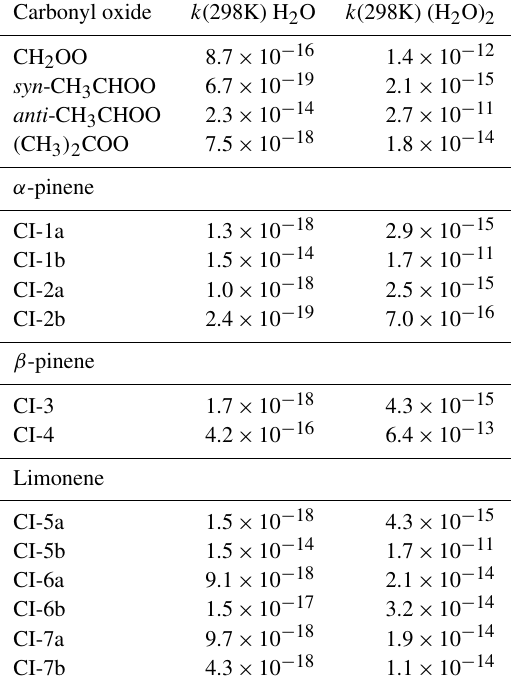
Table 4. Rate coefficients (cm 3 molecule − 1 s − 1 ) for the reaction of CIs with H 2 O and (H 2 O) 2 as predicted by Vereecken et al. (2017). Values are based on explicit CCSD(T)/aug-cc-pVTZ//M06-2X/aug- cc-pVTZ calculations and multi-conformer TST, including empiri- cal corrections to reference experimental data, except for limonene- derived CIs where the values are predicted using a structure–activity relationship. The rate coefficients for CH 2 OO, CH 3 CHOO and (CH 3 ) 2 COO are within a factor of 4 of evaluated literature data (Vereecken et al.,